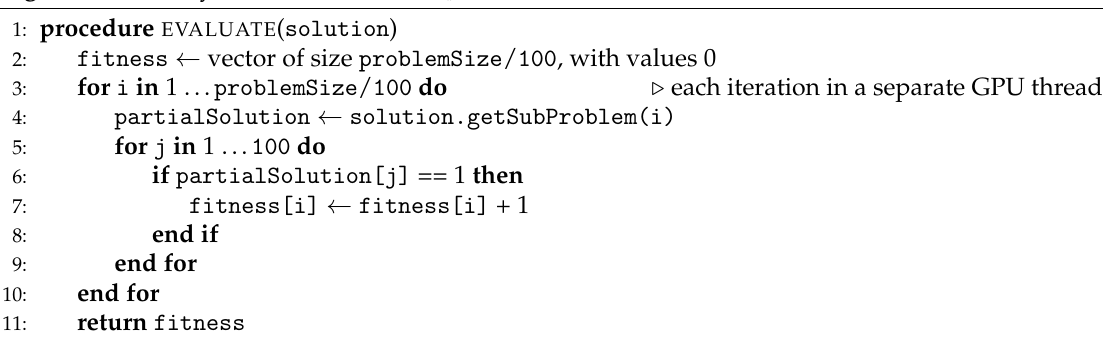
Algorithm 3 Binary cGA-A100: evaluate().